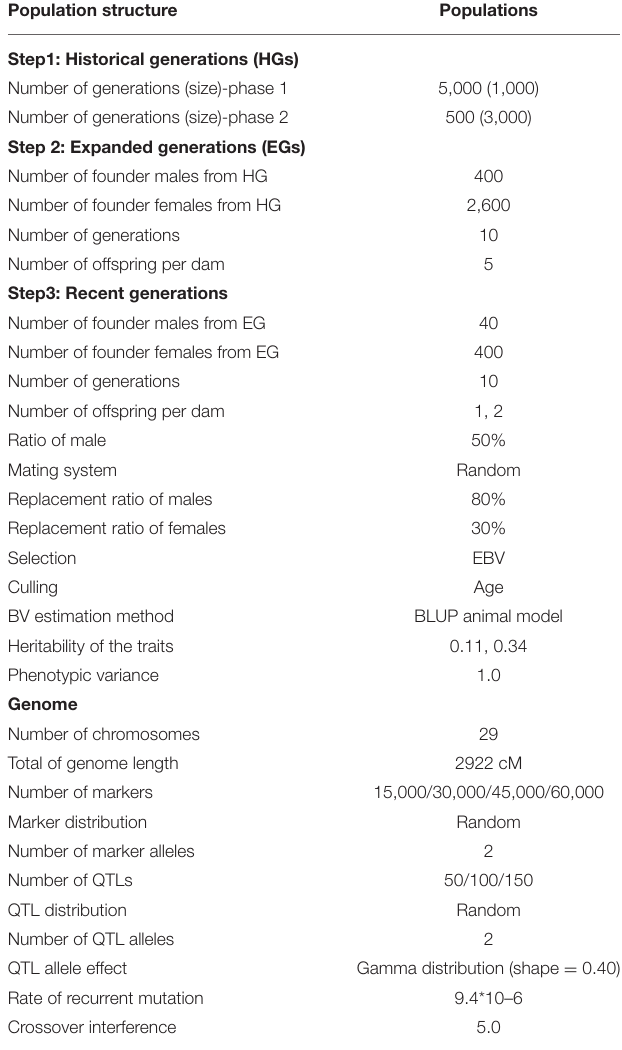
TABLE 1 | Parameters of the simulation